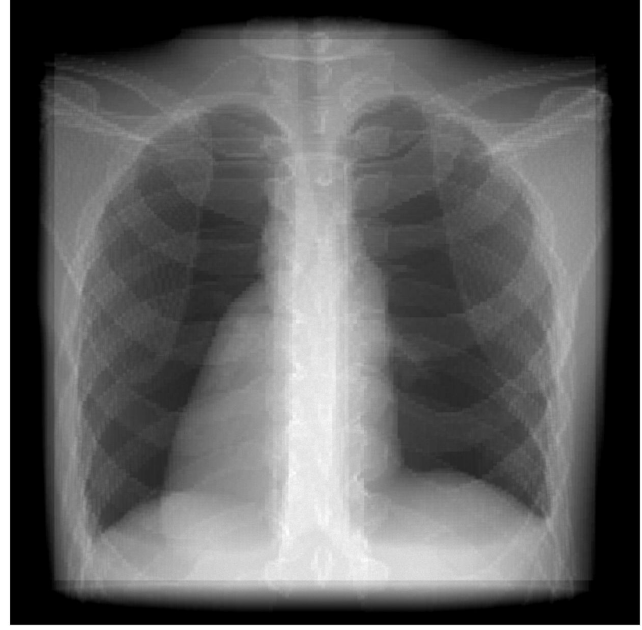
Figure 7. Result for fluoroscopy